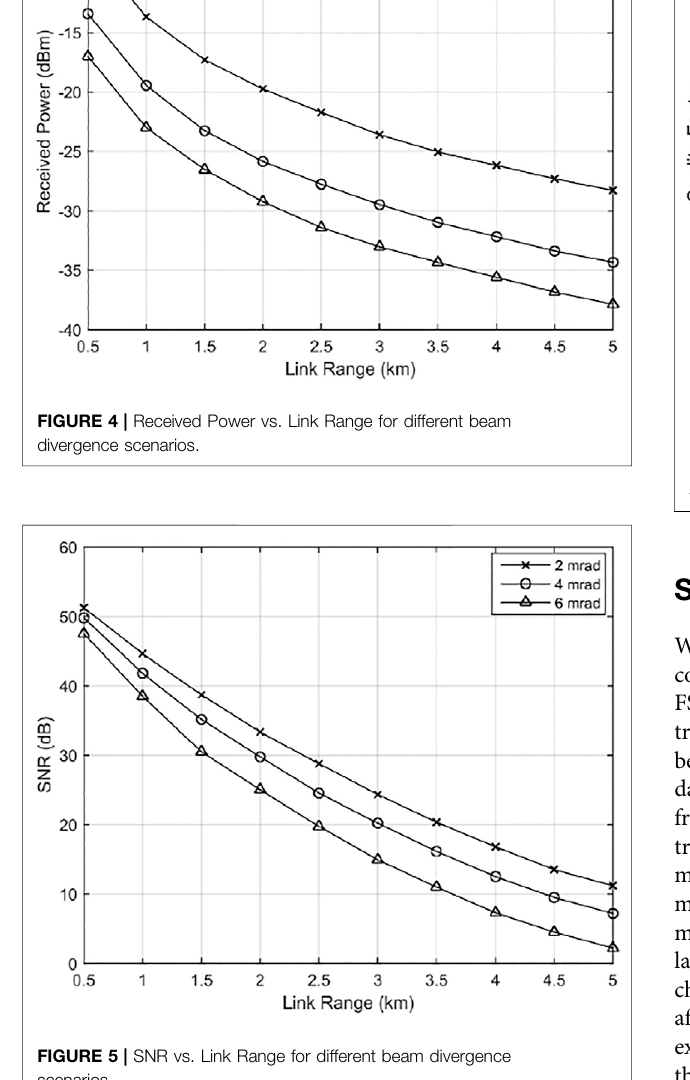
FIGURE 5 | SNR vs. Link Range for different beam divergence scenarios.